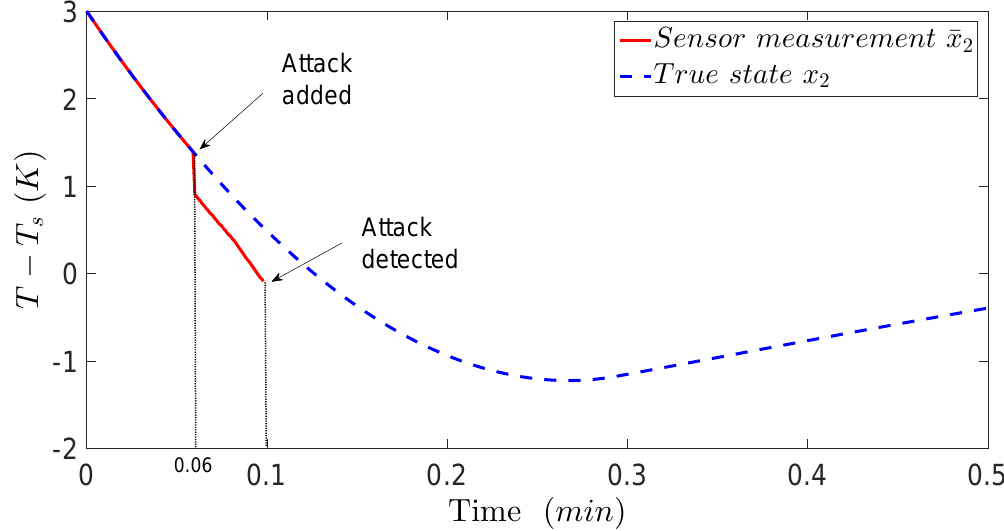
Figure 7. Closed-loop state profiles ( x 2 = T − T s , ¯ x 2 = ¯ T − T s ) for the initial condition ( − 0.25, 3) under the LMPC of Equation (14) and the model-based detection system.